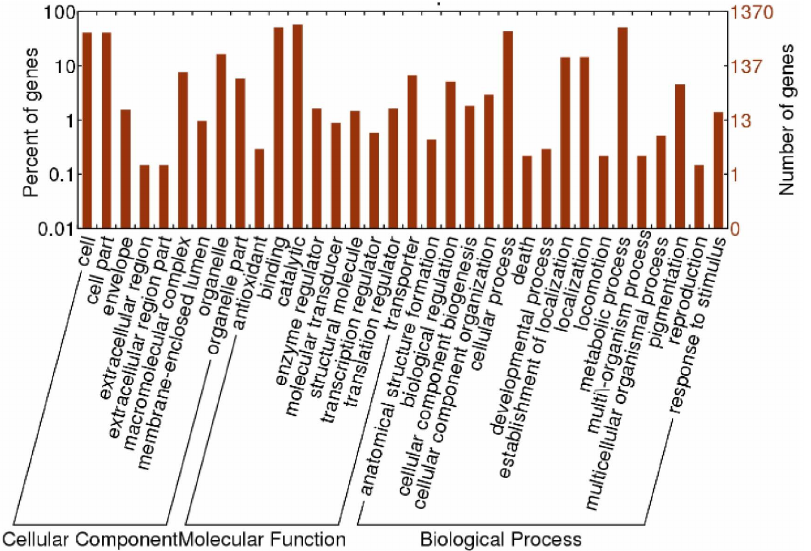
Figure 3. GO categories of the unigenes. The unigenes were mainly annotated in three categories: cellular components, molecular functions and biological processes. The right y-axis denotes the number of genes in a category. The left y-axis denotes the percentage of a specific category of genes in the main category.